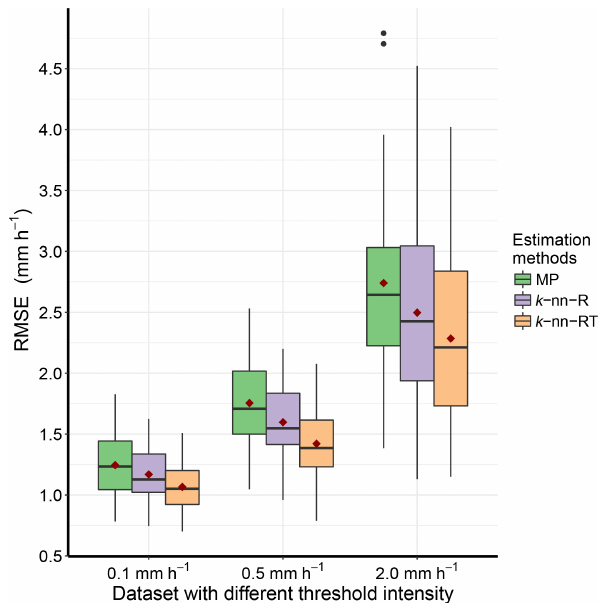
Figure 5. Box plot of RMSE (mmh − 1 ) values estimated at gauge locations for the original data (MP) and the two non-parametric models ( k -nn-R and k -nn-RT) using data with intensities of radar precipitation rate and gauge precipitation greater than or equal 0.1, 0.5 and 2.0mmh − 1 . The mean value of RMSE for each model is denoted by red diamond point. Here, k -nn-R is the non-parametric model with radar precipitation rate as single predictor. k -nn-RT, the non-parametric model with radar precipitation rate and air temper- ature as two predictors, has the partial weight of 0.68, 0.32. The values outside 1.5 × IQR are represented by the